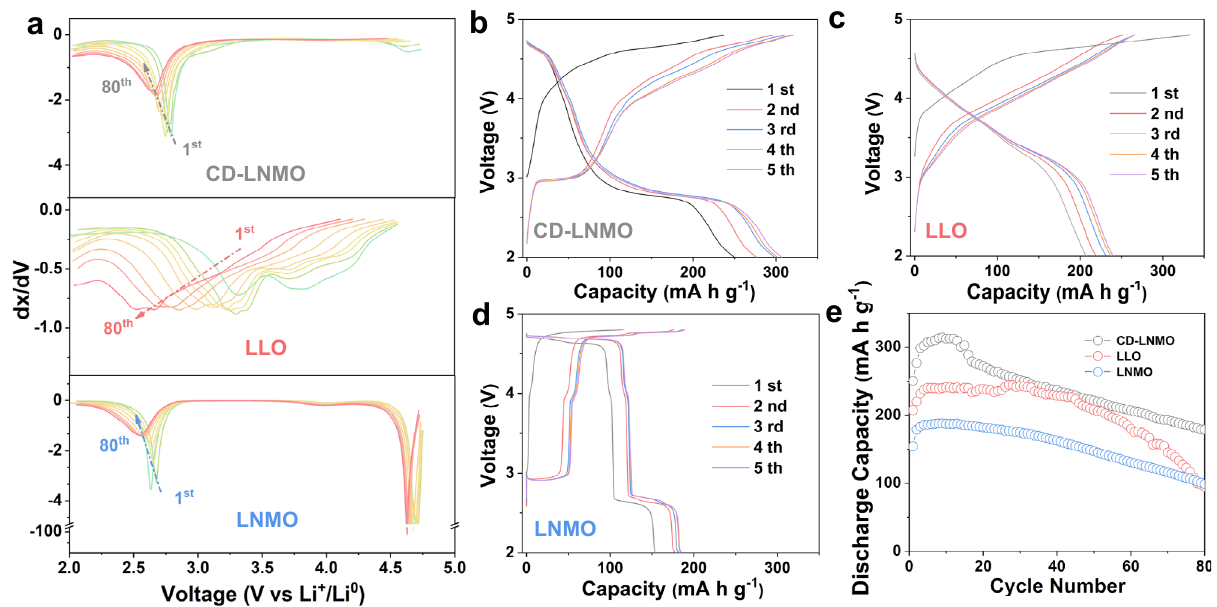
Fig.4|Electrochemicalperformanceofdifferentrocksalt-typetransitionmetal oxidematerials.a Differential capacitycurves ofCD-LNMO, LLO, and LNMO from the1stto80thcycles.Thecyclingtestswereperformedfrom2.0 – 4.8Vataspeci fi c current of 100mAg − 1 , and the curves were plotted every 10 cycles. b – d The